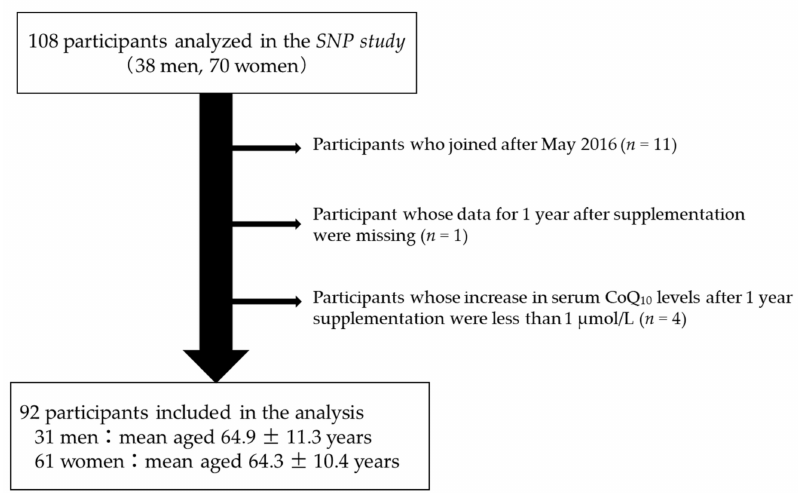
Figure 1. Flow chart of participant selection. Of the 108 participants analyzed in the SNP study, 16 participants were excluded, resulting in 92 participants being ultimately included in the primary